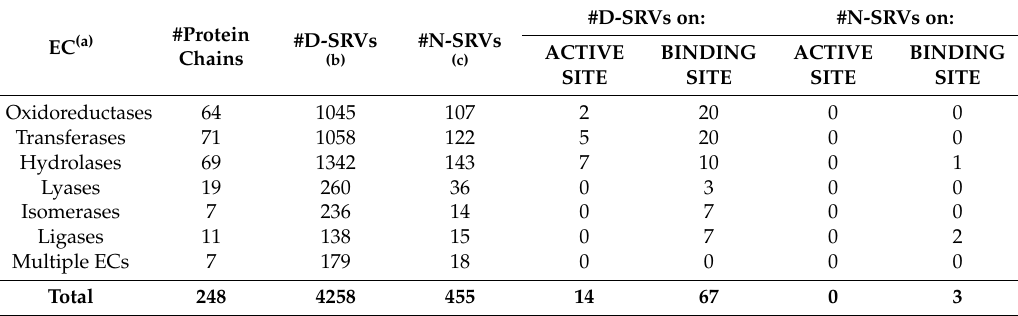
Table 3. Enzymes in